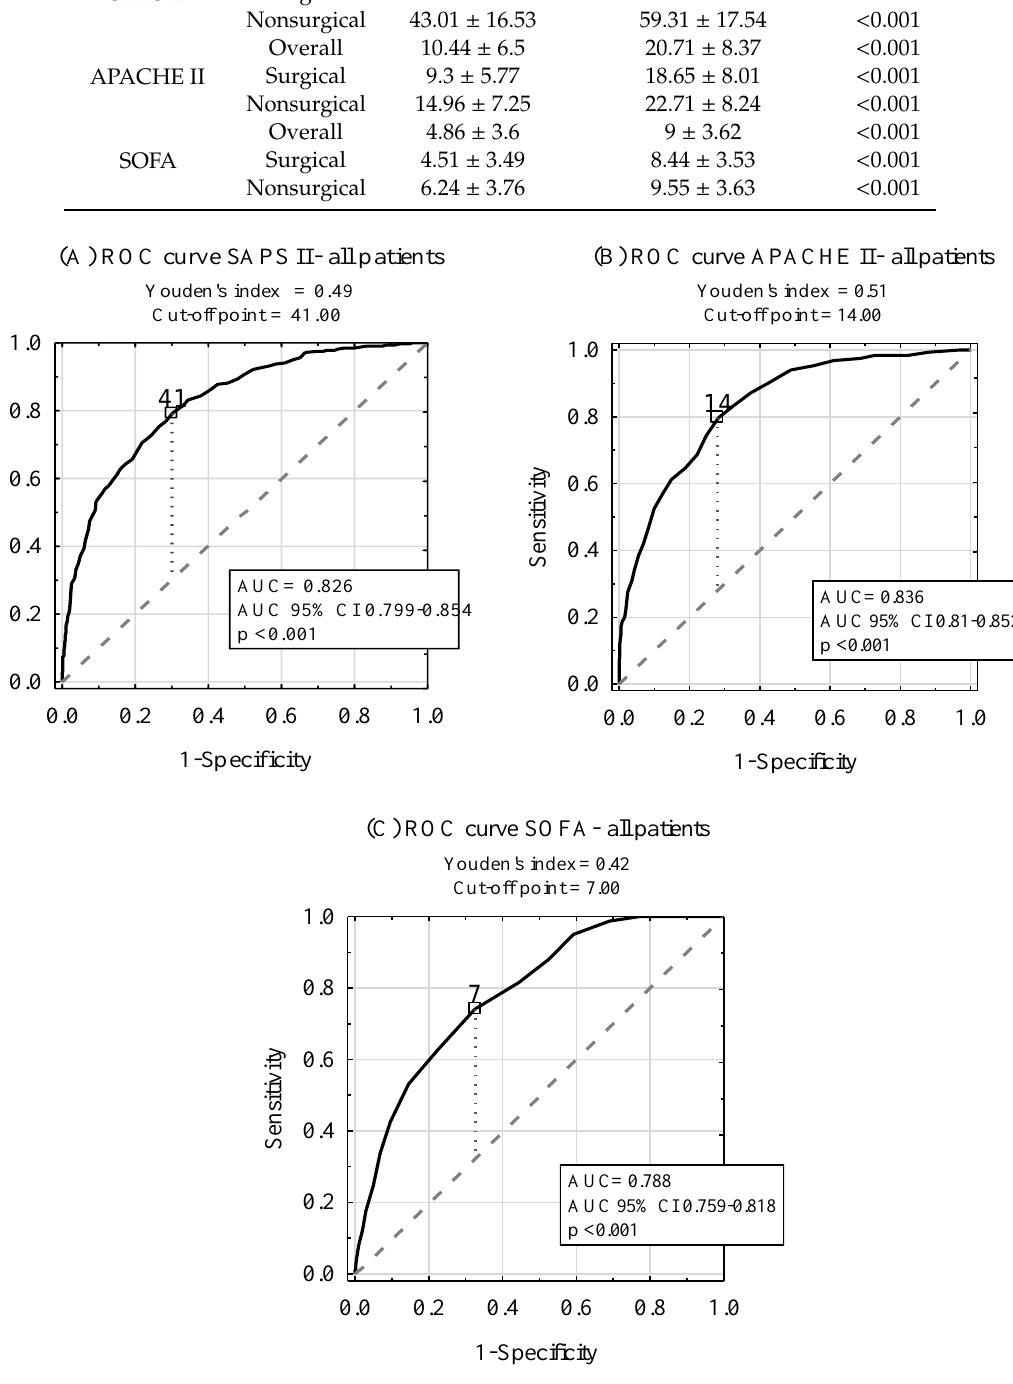
Figure 2. Diagnostic accuracy of SAPS II ( A ), APACHE II ( B ), and SOFA ( C ) scales in ICU mortality prediction.